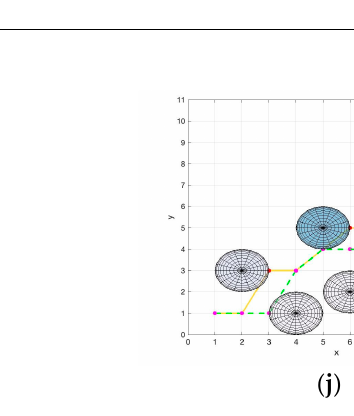
Figure 12. Visualization of path planning results from a certain view ( a – e ) and from a top view ( f – j ).